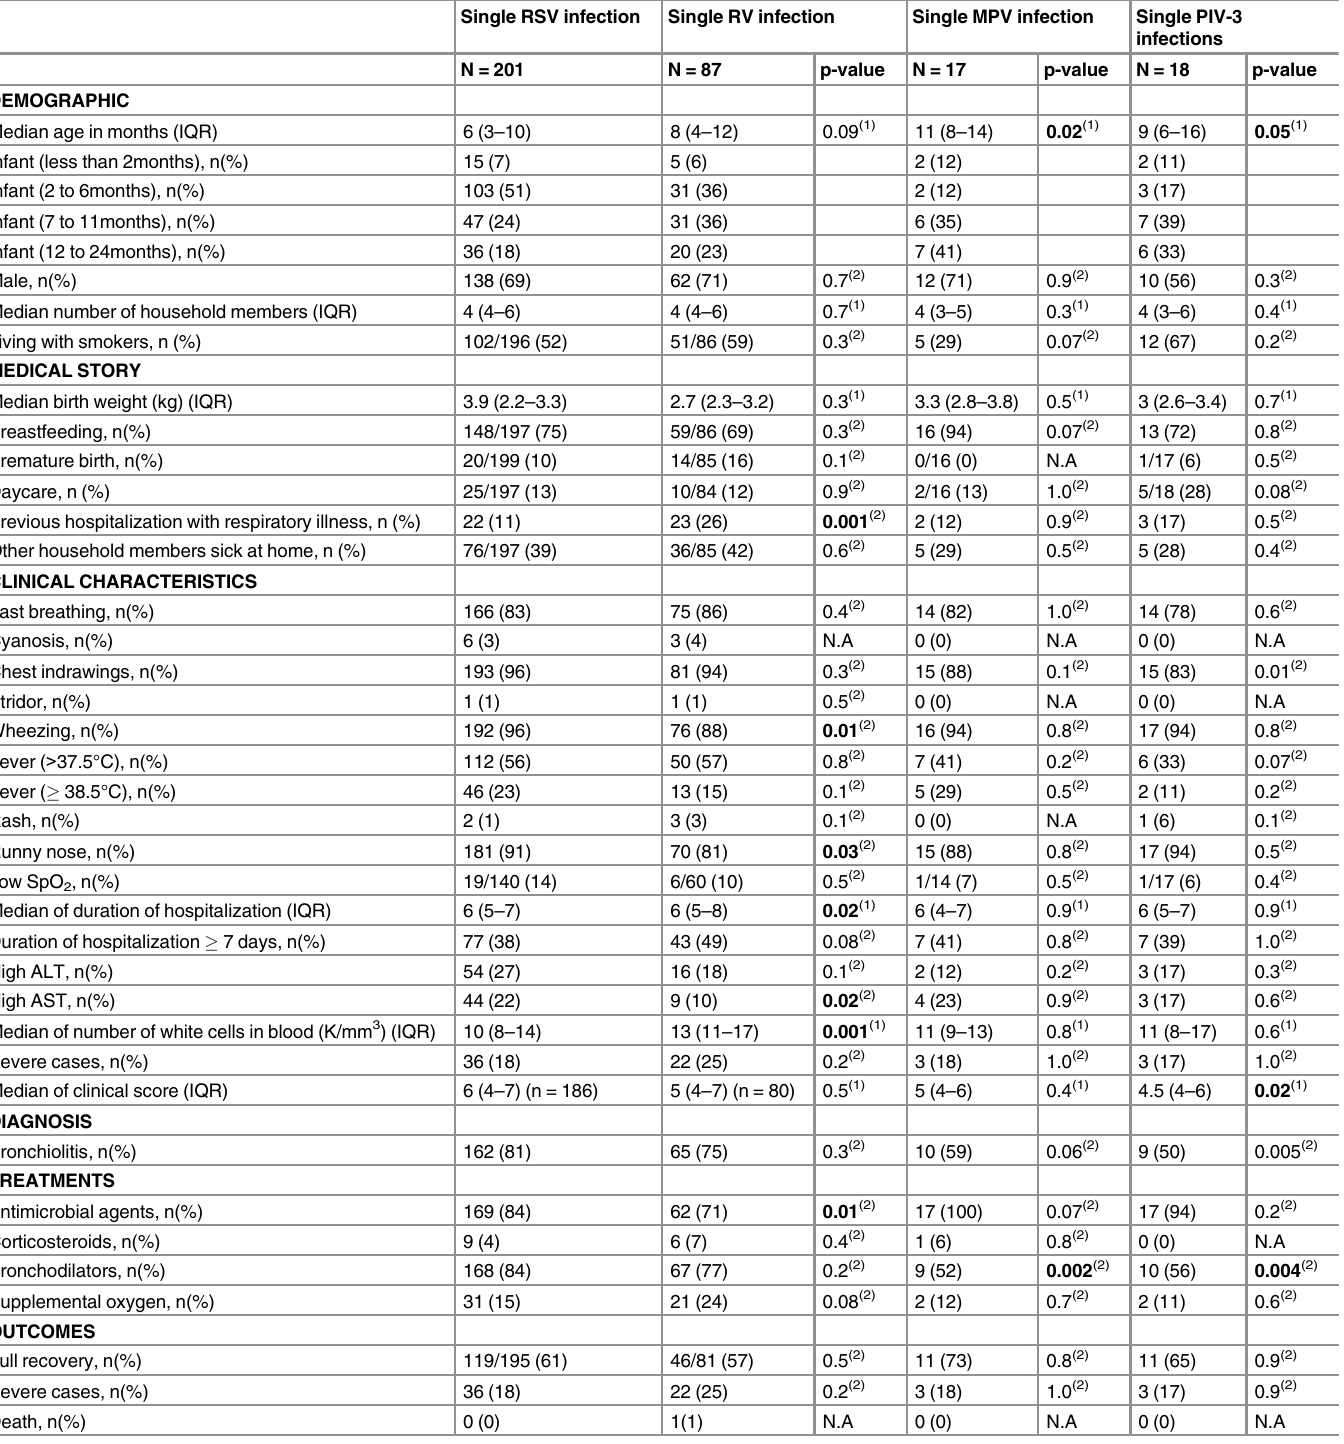
Table 5. Comparison of demographic and clinical characteristics among patients with RSV, RV, MPV and